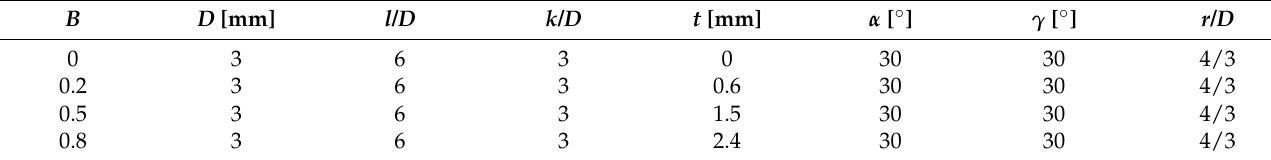
Table 2. Film hole parameters.